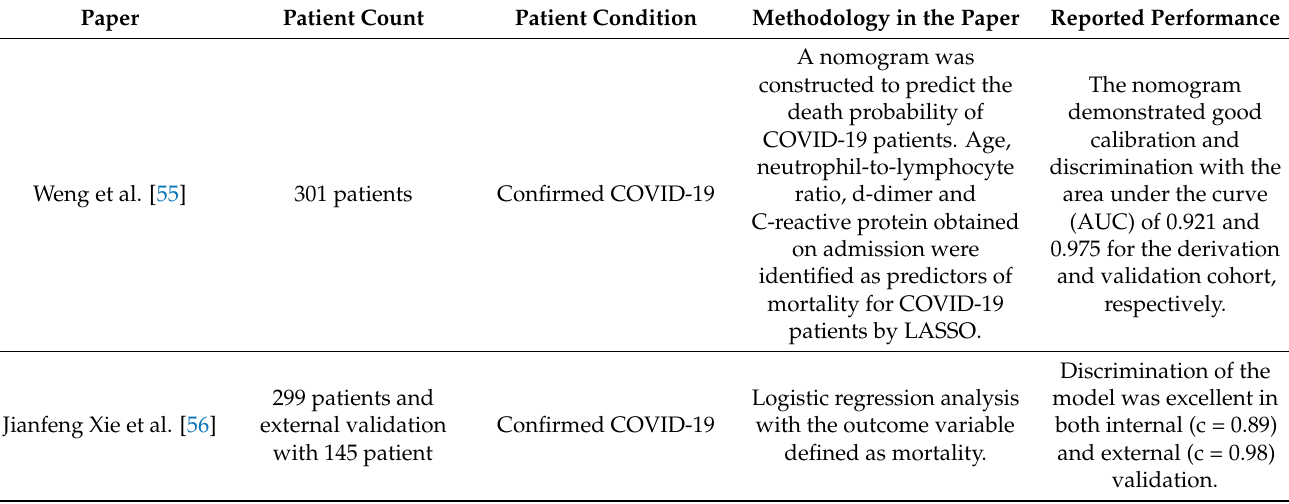
Table 6. Performance comparison with similar recent